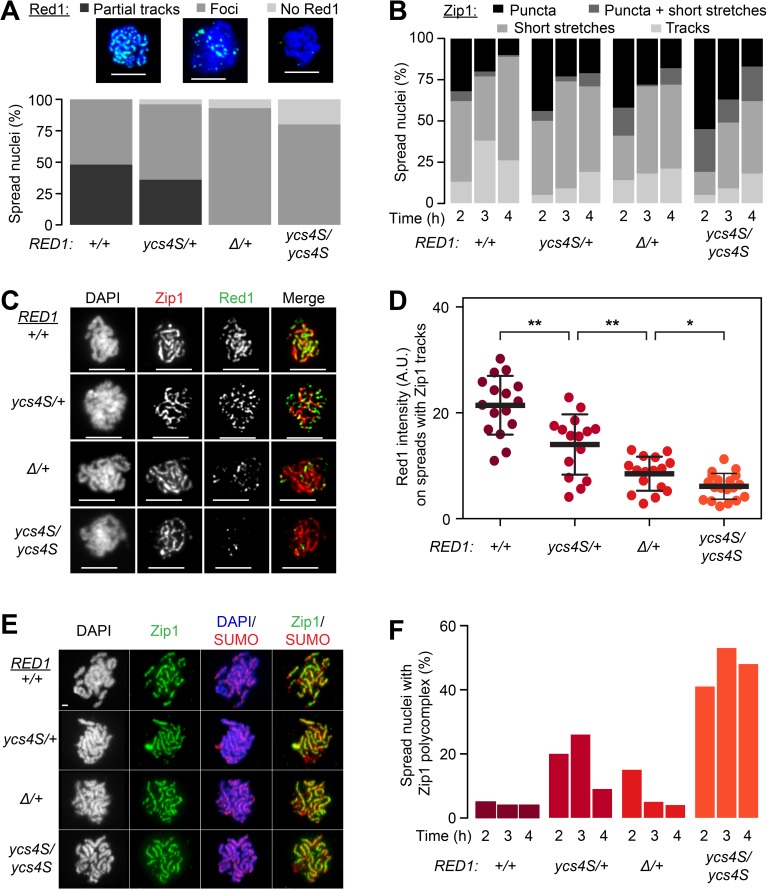
Chromosome synapsis occurs with minimal Red1 protein.(A) Quantification of Red1 binding on spread chromosomes 4h after meiotic initiation from wild-type (+/+, H7797), red1ycs4S/RED1 (ycs4S/+, H8218), red1Δ/RED1 (H8220, Δ/+), and red1ycs4S/red1ycs4S (ycs4S/ycs4S, H7011) strains, n = 100. Only nuclei with detectable Zip1 staining were included. Red1 binding was classified into: “No Red1”, “Only Red1 foci”, and “Partial Red1 tracks”. Scale bars on spreads are 5μm. (B) Zip1 binding on chromosome spreads of wild-type, red1ycs4S/RED1, red1Δ/RED1, and red1ycs4S/red1ycs4S strains, n = 100. Zip1 pattern was classified into: “Puncta”, “Puncta + short stretches”, “Short stretches”, and “Tracks”. (C) Example images of Red1 binding patterns on spreads with Zip1 tracks from (B). Zip1 is colored red, while Red1 is colored green. Scale bars on spreads are 5μm. (D) Red1 intensity levels on chromosome spreads with Zip1 tracks, measured as described for Fig 3C, n>15. Error bars: S.D. *: p-value < 0.05, **: p-value < 0.005 Wilcox test. Samples range in color from dark purple to orange as they transition from highest Red1 level to lowest. (E) Representative images of SUMO binding patterns on spreads with Zip1 tracks from (B). Zip1 is colored green, DAPI is colored blue, and SUMO is colored red. Scale bars are 1μm. (F) Frequency of Zip1 polycomplex formation in the spreads from (B). Scale bars on spreads are 5μm.